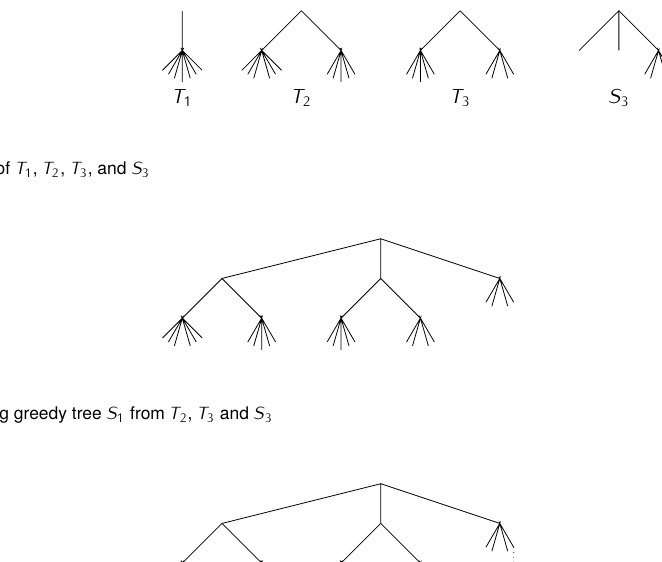
Figure 7. The alternating greedy trees